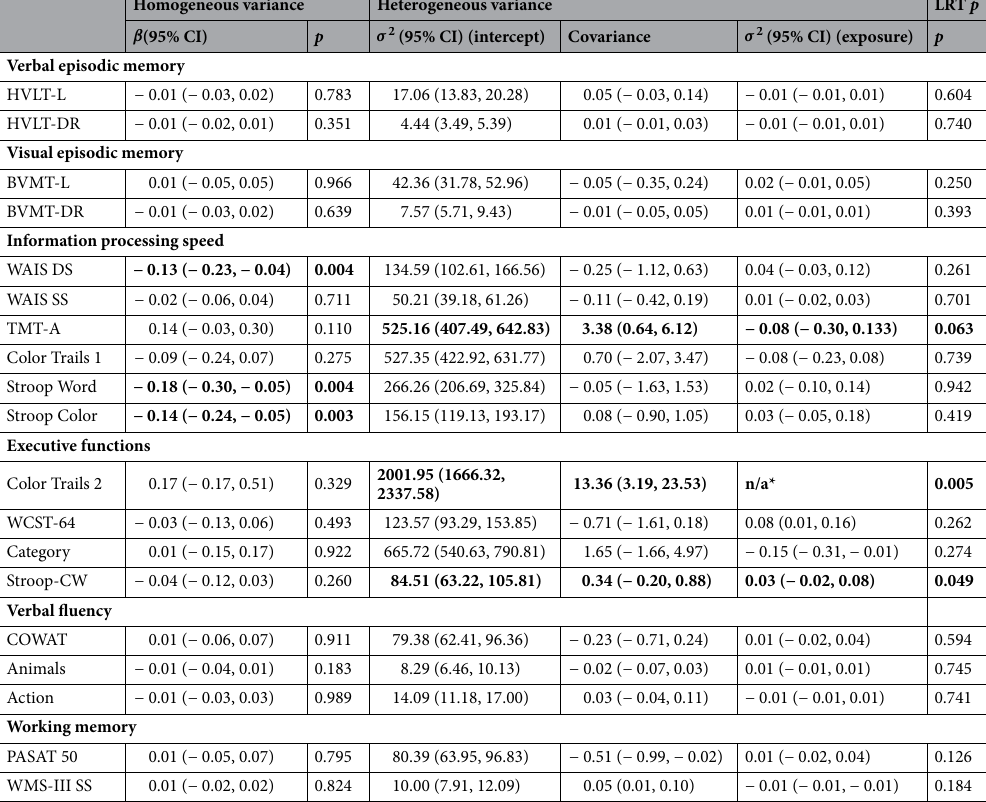
Table 4. Coefficients for the constant variance [ β (95% confidence interval)] and complex level-1 models 2 [ σ (95% confidence interval] of exposure to childhood trauma as assessed by continuous score on the CTQ (Childhood Trauma Questionnaire) regressed on individual tests of neurocognitive performance, controlling for covariates. Log-likelihood ratio test (LRT) values comparing the variance estimates from OLS models with complex level-1 models are reported in the last column. All models adjusted for age, education level, HIV status, marital status, employment status, income, depression and PTSD symptoms levels. Mean and variance estimates that lie between − 0.01 and 0.01 were rounded to the closer of the either values. The rounding does not influence the inference as these estimates were not noticeably different from zero. Some variance estimates were allowed to be negative, which is intuitively confusing. However, these estimates should be interpreted as part of a variance function, which is non-negative. LRT loglikelihood ratio test, WCST Wisconsin Card Sorting Test, Stroop-CW Stroop Color-Word Incongruence, TMT-A Trail Making Test, Version A, WAIS - III DS WAIS- III Digit Symbol, WAIS-III S–S WAIS-III Symbol Search, HVLT-R , L Hopkins Verbal Learning Test, Revised, Learning, HVLT-R, DR Hopkins Verbal Learning Test, Revised, Delayed Recall, BVMT-R, L Brief Visuospatial Memory Test, Revised, Learning, BVMT-R, DR Brief Visuospatial Memory Test, Revised, Delayed